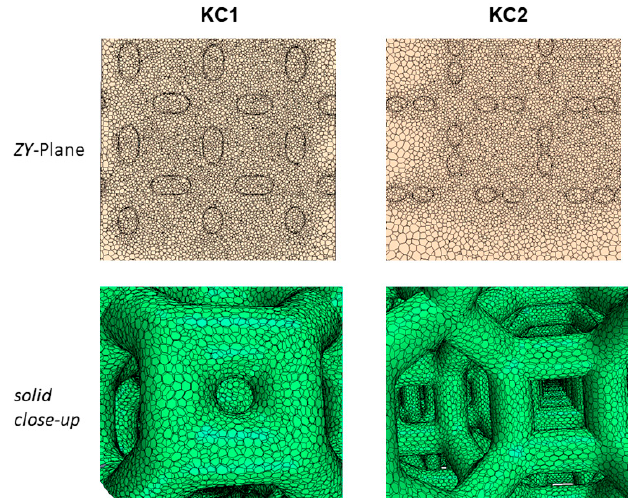
Figure A1. Depiction of volume meshes that were used in this study.